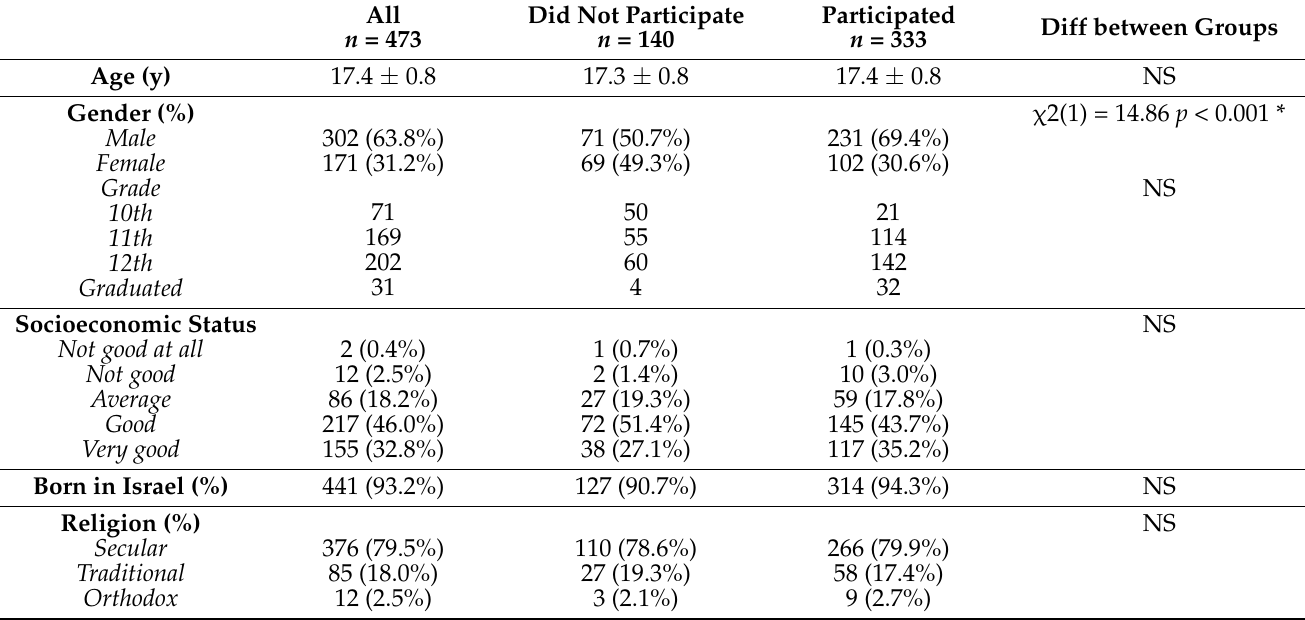
Table 1. Characteristics of the 473 adolescents who took part in the study, grouped by participation in online group meetings of organized sports programs during the COVID-19